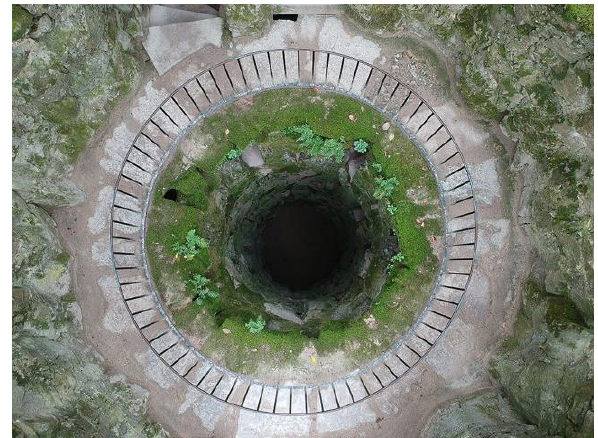
Figure 7 . The Quinta da Regaleira in Sintra, the Poço Imperfeito , drone image.